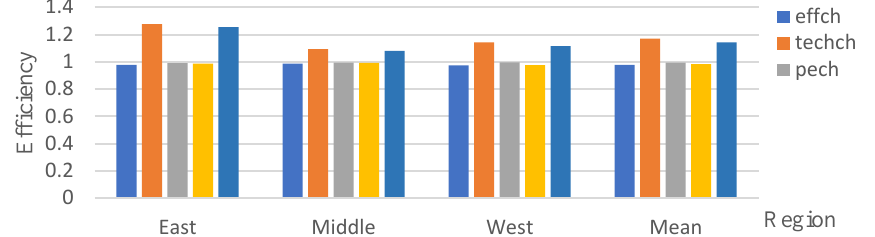
Figure 6. Malmquist index of Implementation Efficiency of Green Buildings in Each Region. Table 9. Malmquist Index and Its Decomposition of Green Buildings’ Management Efficiency in Each Region.